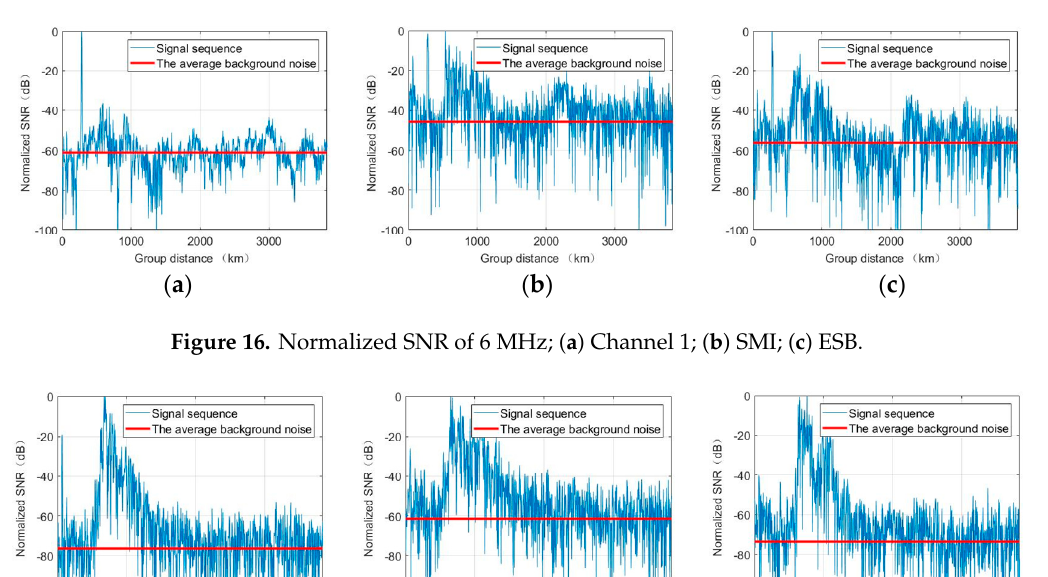
Figure 16. Normalized SNR of 6 MHz; ( a ) Channel 1; ( b ) SMI; ( c ) ESB.